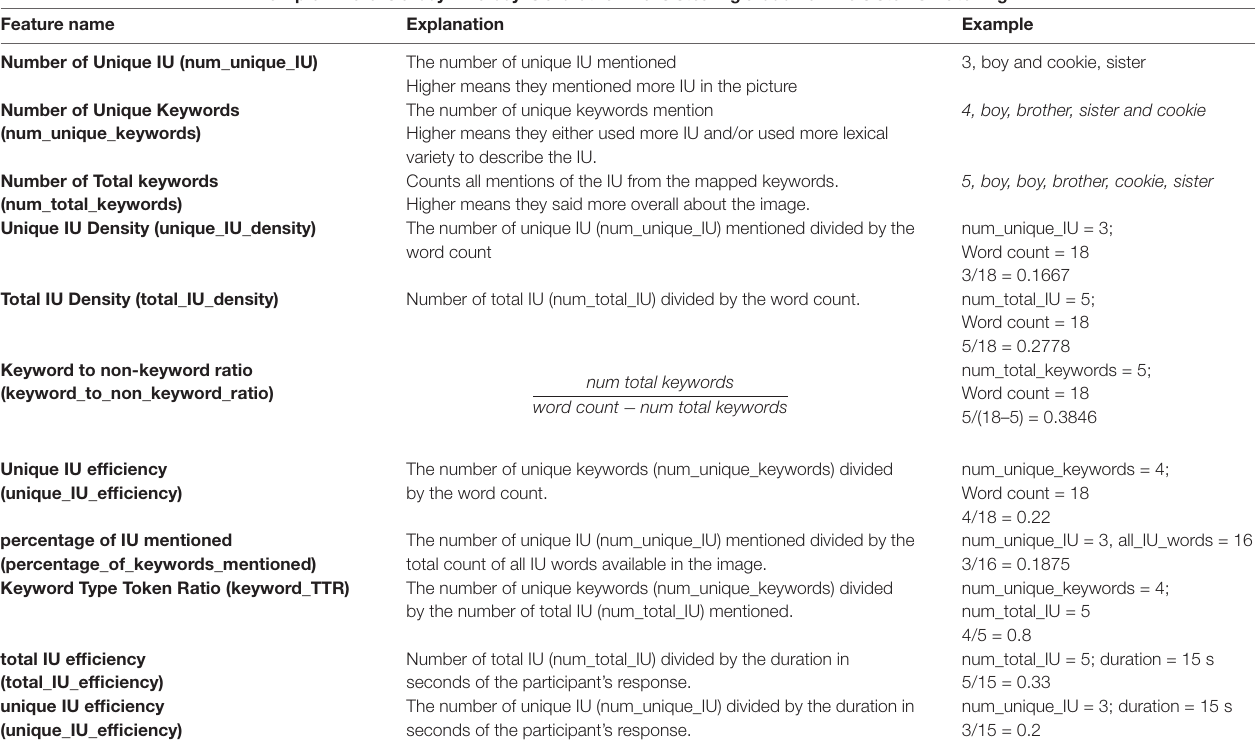
TABLE 2 | Explanation of semantic